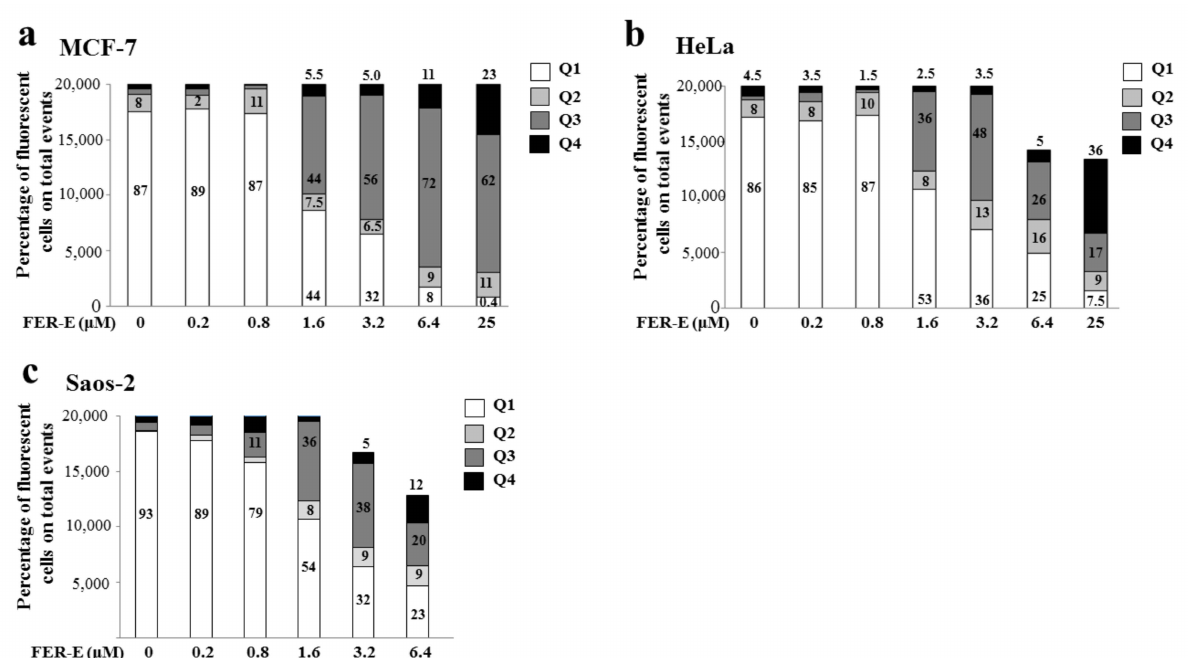
Figure 7. Expression of results obtained by Annexin V Staining assay. The results of three independent experiments, obtained by Annexin V Staining assay are shown. In particular, the percentage of cellular fluorescence in the total number of events (20,000) has been evaluated and indicated in the relevant box. In panels ( a – c ) the quantifications of MCF7, HeLa and Saos-2 cell lines are shown respectively. Data from an indicative experiment (of 3 independent experiments with similar results) are